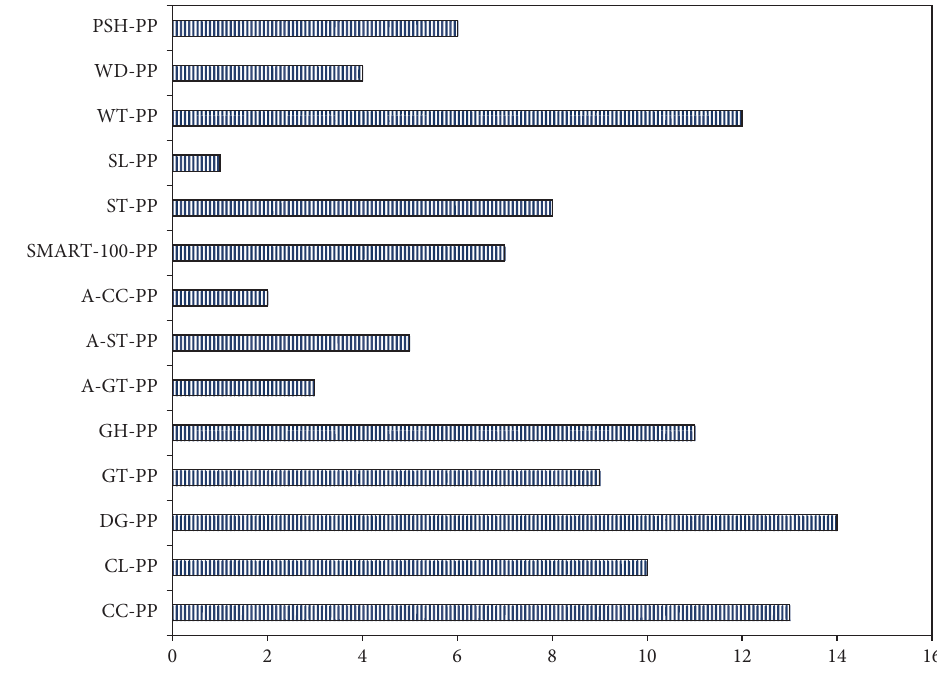
Figure 12: Ranking of power plant technologies by 2050 for Subscenario III-2.